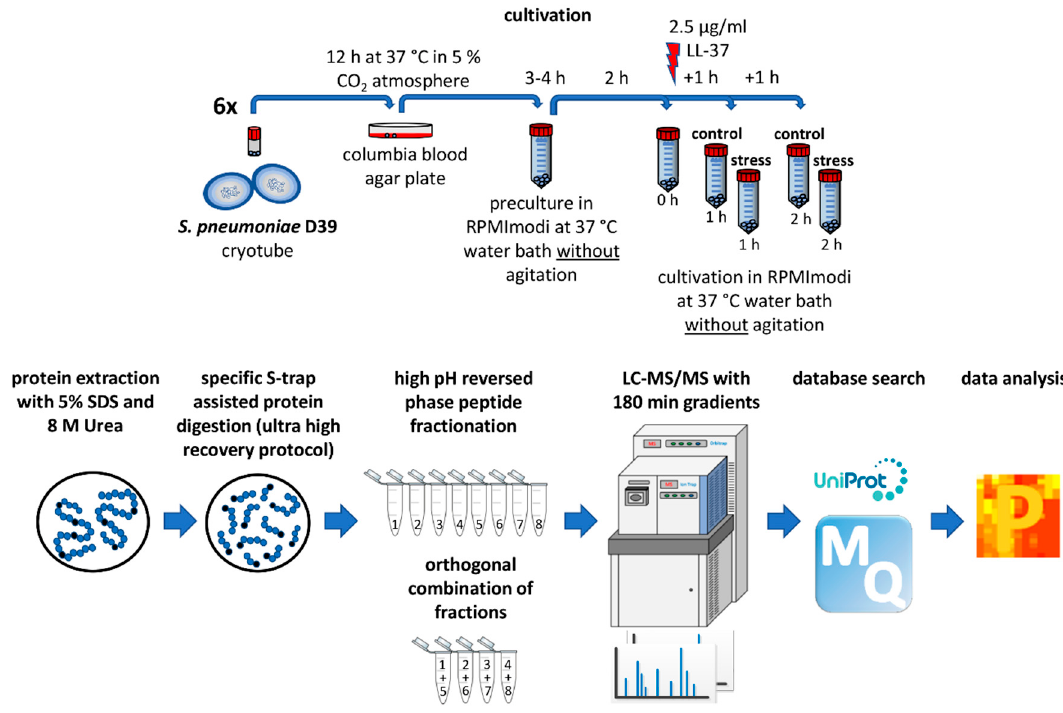
Figure 1. Established workflow for proteomic investigation of LL-37 stress on pneumococci.